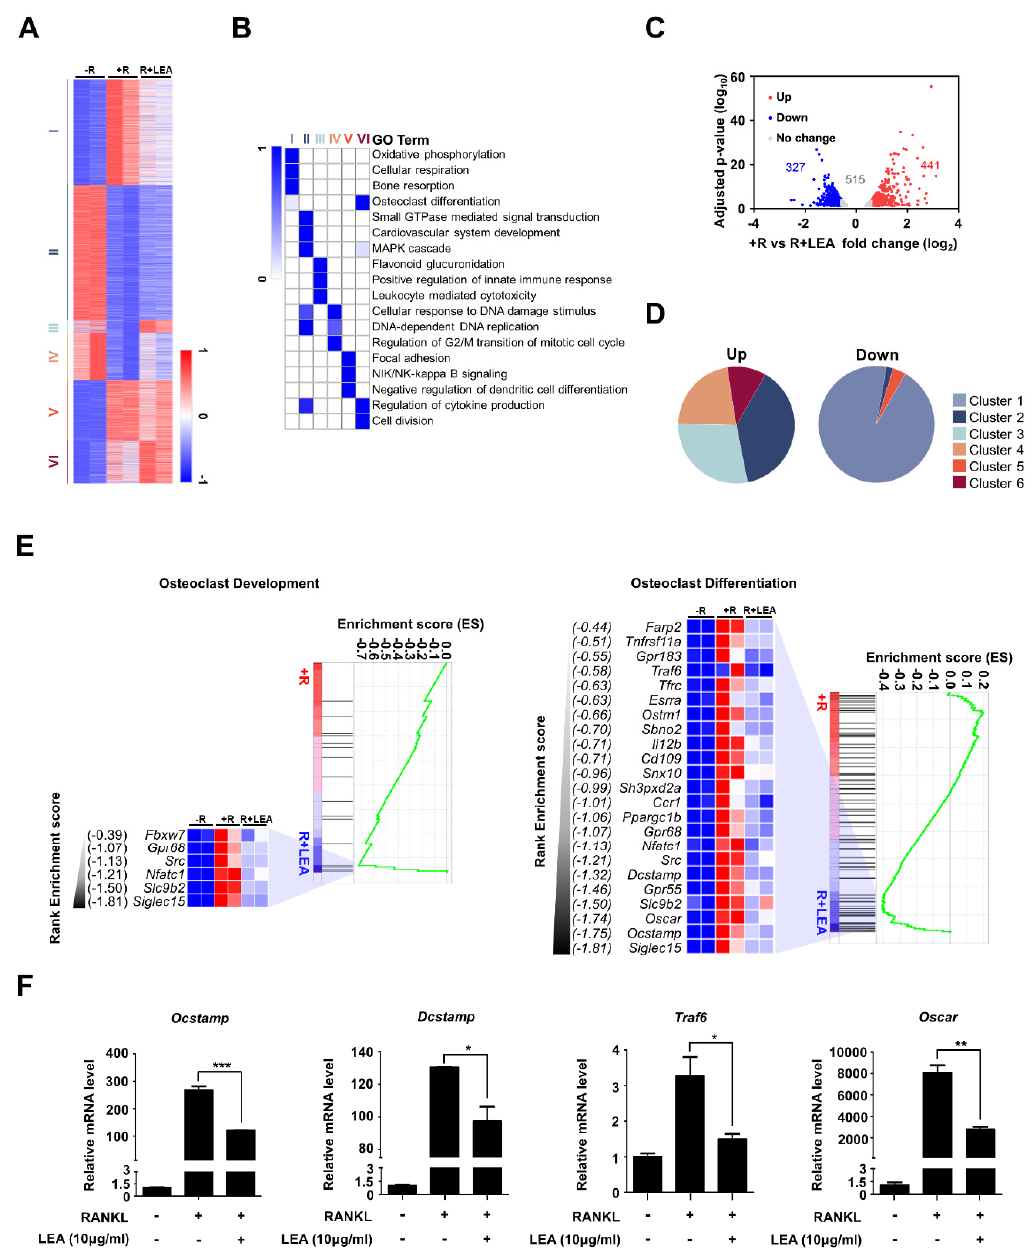
Figure 2. LEA alters gene expression profiling in BMMs. ( A ) K-means (K = 6) clustering of 4740 differentially expressed genes (DEGs) in any pairwise comparison among three conditions ( − R; no RANKL, + R; RANKL, R + LEA; ethyl acetate fraction of L. edodes with RANKL). Clusters are indicated on the left. ( B ) Heatmap showing the p -value significance of GO term enrichment for genes in each cluster. ( C ) Volcano plot of transcriptomic changes between + R and R + LEA. Genes with increased (red) or decreased (blue) expression in LEA + RANKL-treated cells relative to RANKL-treated cells were defined based on FDR-adjusted p < 0.05 and greater than 1.5-fold expression changes. ( D ) Pie charts showing each cluster portion of as in (C). Up: Cluster 1 (0%), Cluster 2 (38.5%), Cluster 3 (28.3%), Cluster 4 (22.2%), Cluster 5(0%), and Cluster 6 (11%). Down: Cluster 1 (94.5%), Cluster 2 (1.8%), Cluster 3 (0%), Cluster 4 (0%), Cluster 5 (3.7%), and Cluster 6 (0%). ( E ) GSEA of 4740 genes as in (A) shows the enrichment of genes associated with osteoclast development and osteoclast differentiation. Heatmap represents core enriched genes based on their enrichment score. ( F ) qRT-PCR was performed to quantify relative mRNA levels of the representative genes for osteoclastogenesis. Error bars represent the mean result ± SD of three independent experiments; * p < 0.05, ** p < 0.01, *** p <